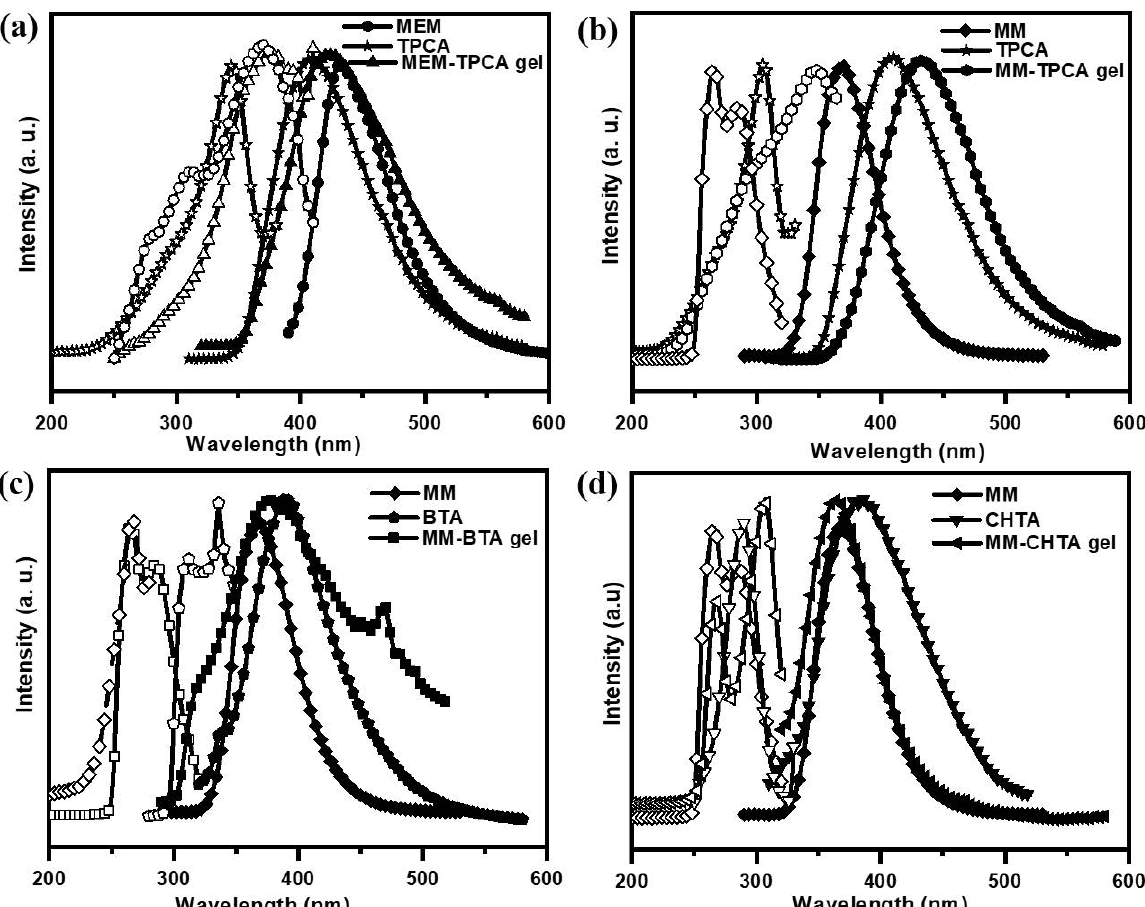
Figure 6. Fluorescence excitation and emission spectra of ( a ) MEMTPCA, ( b ) MM–TPCA, ( c ) MM– BTA and ( d ) MM–CHTA hydrogel network (1:1) and individual moieties (MM, MEM, TPCA, BTA and